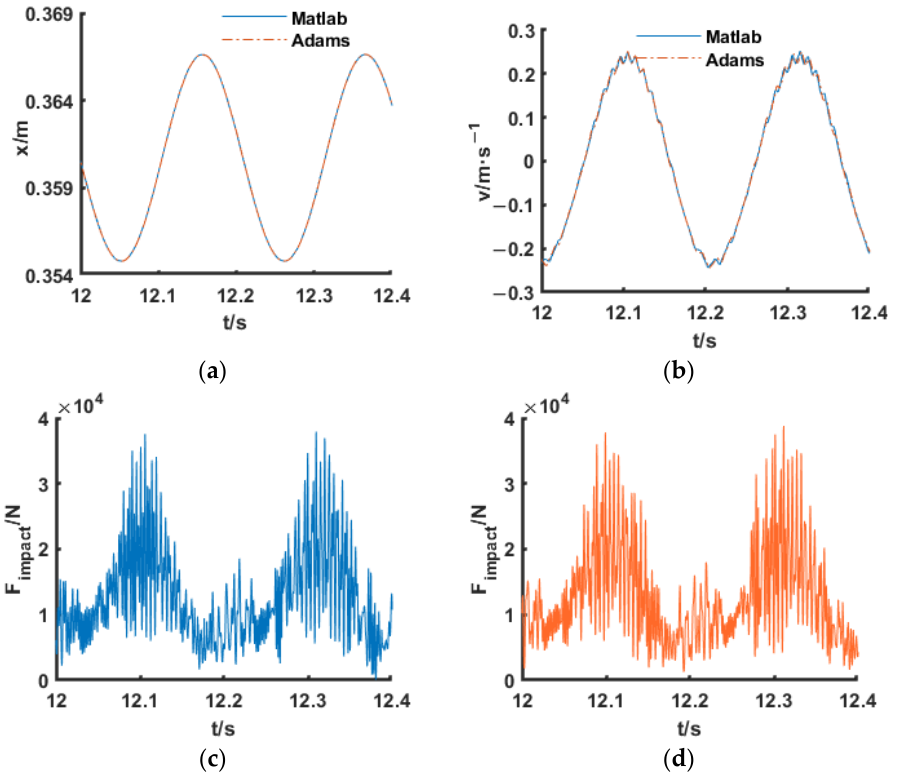
Figure 5. Comparison of results from Adams and MATLAB: ( a ) Moveable jaw displacement; ( b ) Moveable jaw velocity; ( c , d ) Collision force at the revolute joint A.